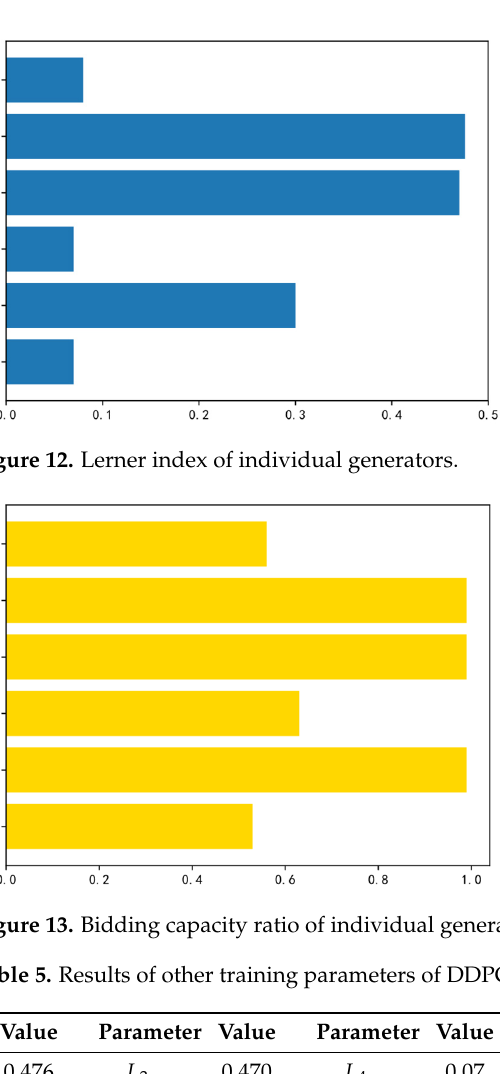
Figure 11. DDPG training revenue results of each generator.